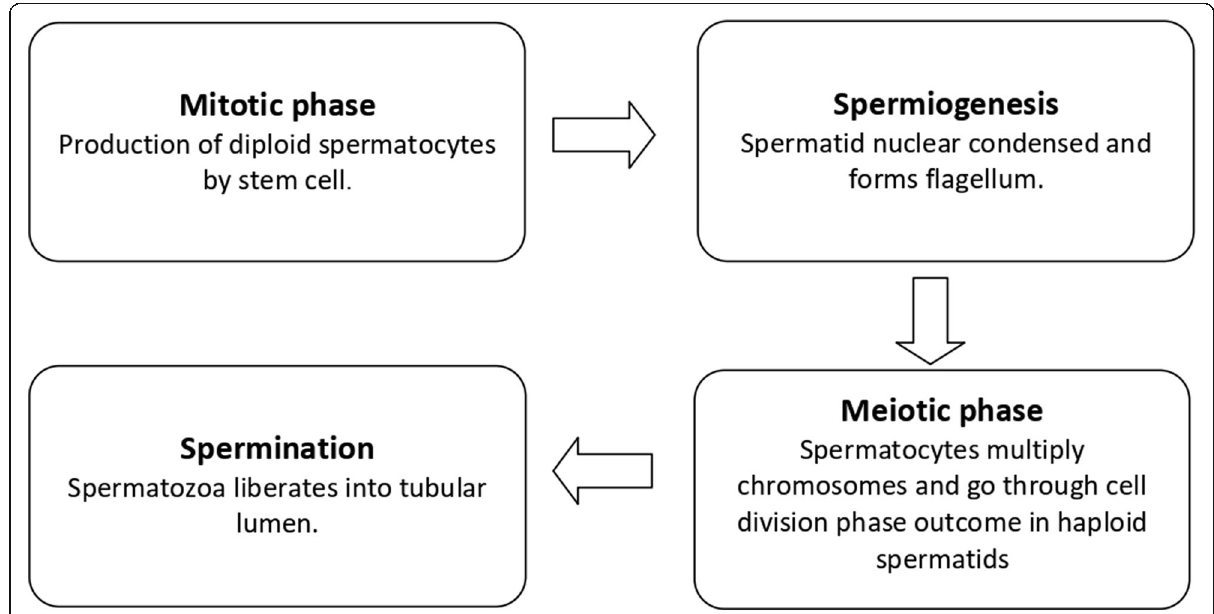
Fig. 1 Different phases by which sperm formation takes